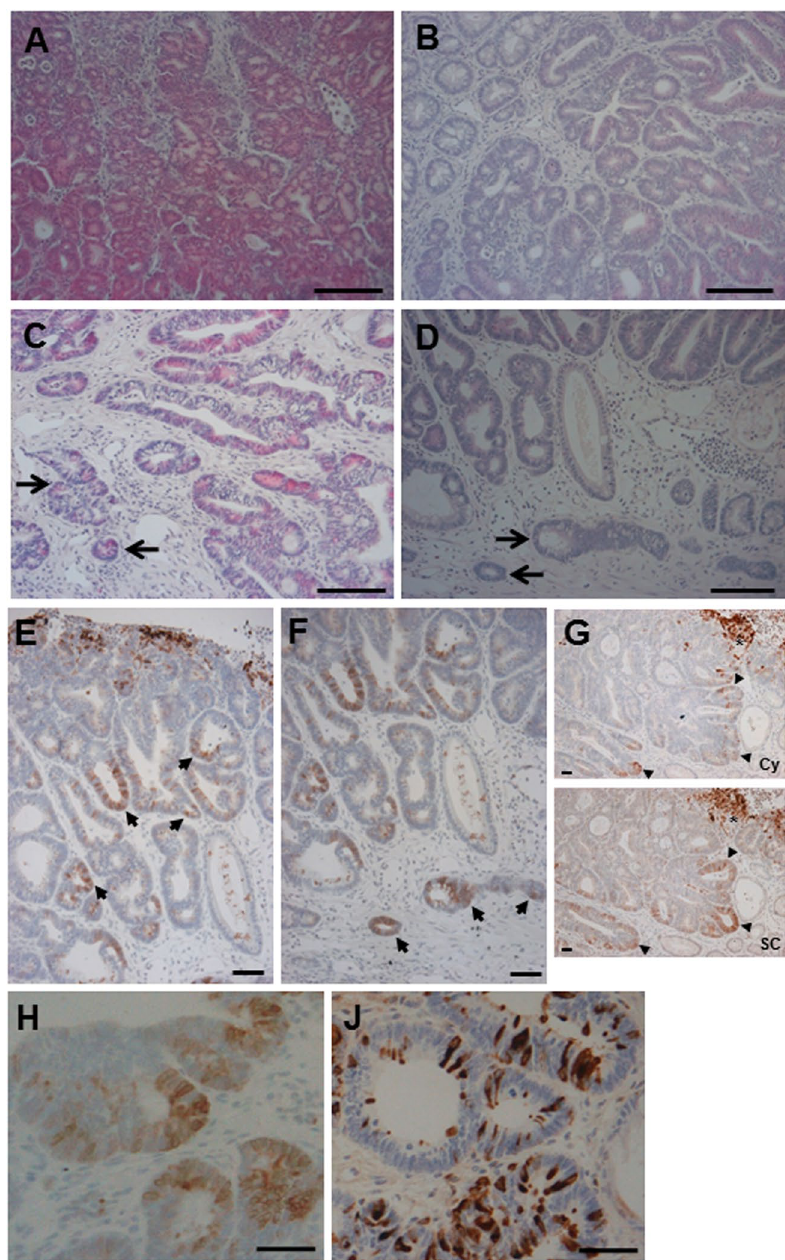
Figure 4. Histological features of cLys-Cox-2 x Apc Min/ + mouse colonic tumours stained with H&E. ( A ) cLys- Cox-2 x Apc Min/ + mouse colonic tumour demonstrating disorganised clusters of severely dysplastic epithelial cells. Size bar = 50 μ m. ( B ) Non-transgenic Apc Min/ + mouse colonic tumour demonstrating typical features of low-grade dysplasia. Size bar = 50 μ m. ( C and D ) Separate cLys-Cox-2 x Apc Min/ + mouse colonic tumours demonstrating invasion of neighbouring submucosa by dysplastic epithelial cells (arrows). ( E ) Patchy dysplastic epithelial cells staining for Cox-2 (arrows) in a cLys-Cox-2 x Apc Min/ + mouse colonic tumour (stromal Cox-2 score 4). Size bar = 50 μ m. ( F ) Epithelial cell Cox-2 protein localization in cells at the base of a cLys-Cox-2 x Apc Min/ + mouse colonic tumour (arrows). Size bar = 50 μ m. ( G ) Adjacent sections of a cLys-Cox-2 x Apc Min/ + mouse colonic tumour stained with either the Cayman (Cay) or Santa Cruz (SC) anti-Cox-2 antibody. Note prominent patchy epithelial cell staining (arrowheads) in addition to stromal cell staining (asterisk) in the same distribution in both panels. In general, adenomatous epithelial cell staining with the Santa Cruz antibody was consistently more widespread than with the Cayman antibody. Size bars = 50 μ m. Immunohistochemistry for Cox-2 (using the Cayman antibody [ H ]) and lysozyme ( J ) on adjacent sections of a cLys-Cox-2 x Apc Min/ + mouse colonic tumour. Size bars = 50 μ m. There was no correlation between Cox-2 and lysozyme immunoreactivity in individual adenomatous epithelial